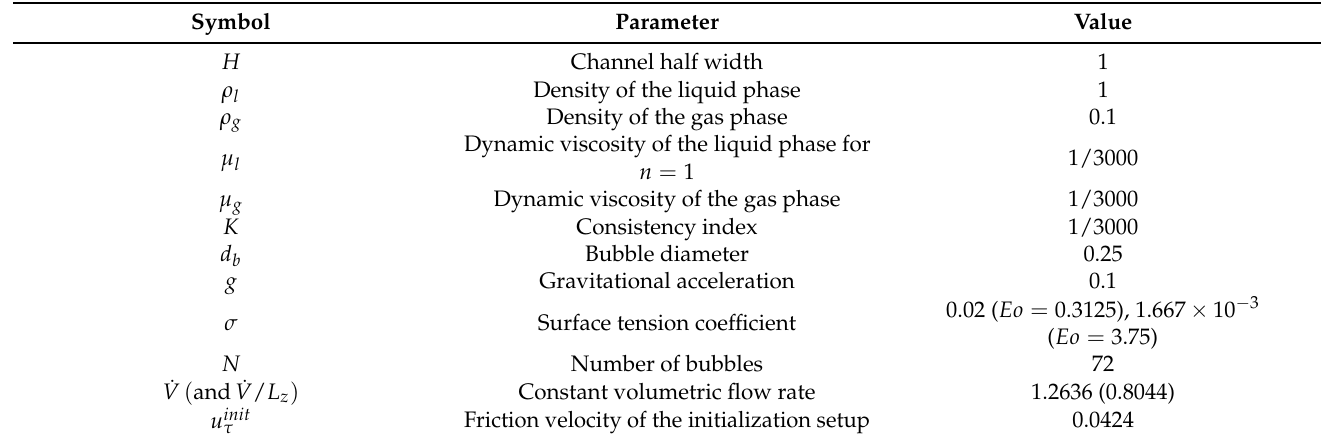
Table A1. Parameters for the case